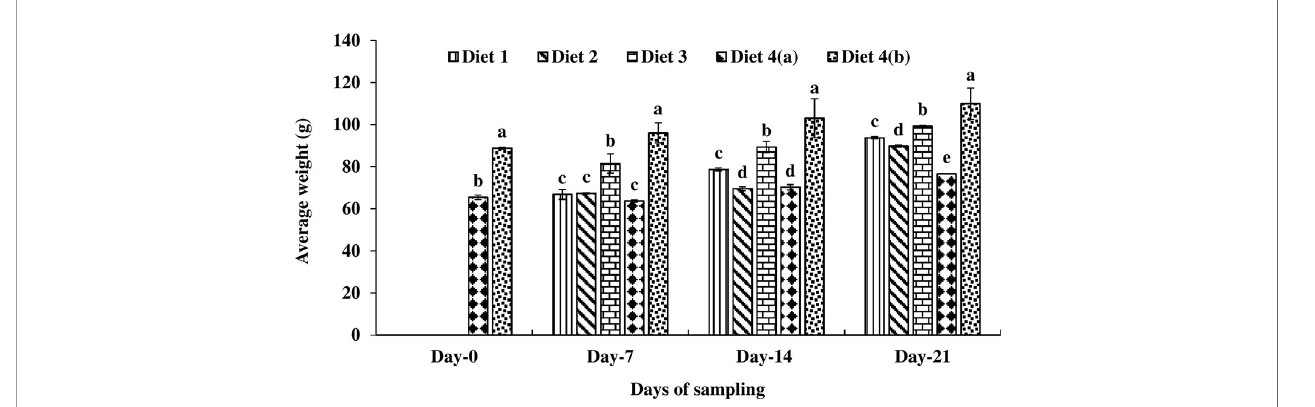
FIGURE 1 | Average weight of four different diets fed UV-B exposed and unexposed Catla catla . Bars with different superscripts (a-e) are signi fi cantly different (n =